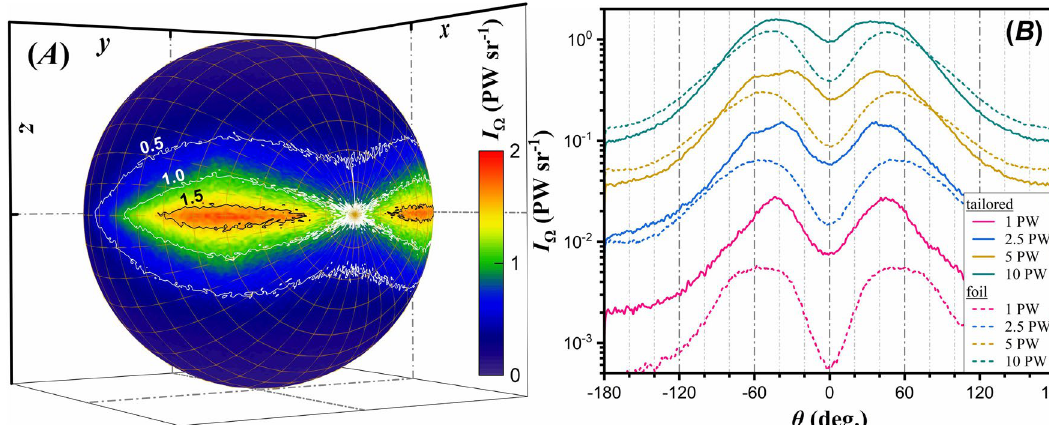
Figure 6. ( A ) Radiant intensity of γ -photons due to the interaction of a 10PW laser with a tailored lithium target. ( B ) Line-out of the radiant intensity of γ -photons, taken along the polarization plane and within a full- angle divergence of 10 o . The solid lines correspond to tailored lithium targets and the dashed lines to foil targets, for various laser powers as noted in the legend.